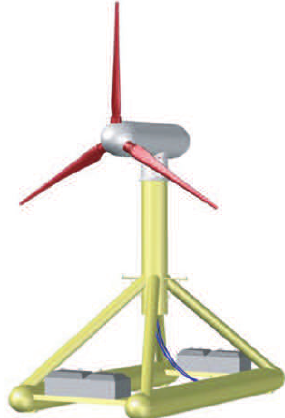
Figure 3. Example of TEC used for manual installation and maintenance maneuvers. Additional details about this TEC design can be found in